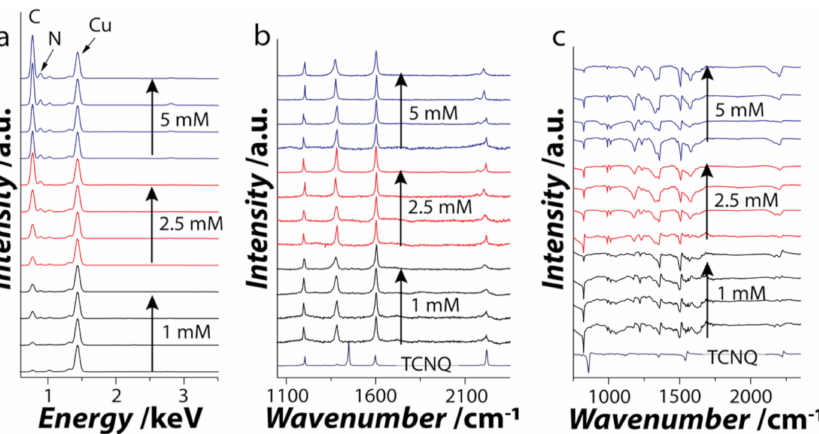
Figure 3. Spectroscopic characterization of CuTCNQ. ( a ) Energy dispersive X-ray (EDX), ( b ) Raman and ( c ) Fourier-transform infrared (FTIR) spectra of CuTCNQ grown on Cu foil using 1 mM, 2.5 mM, and 5 mM TCNQ in DMSO with increasing concentration of water (0, 5, 15,